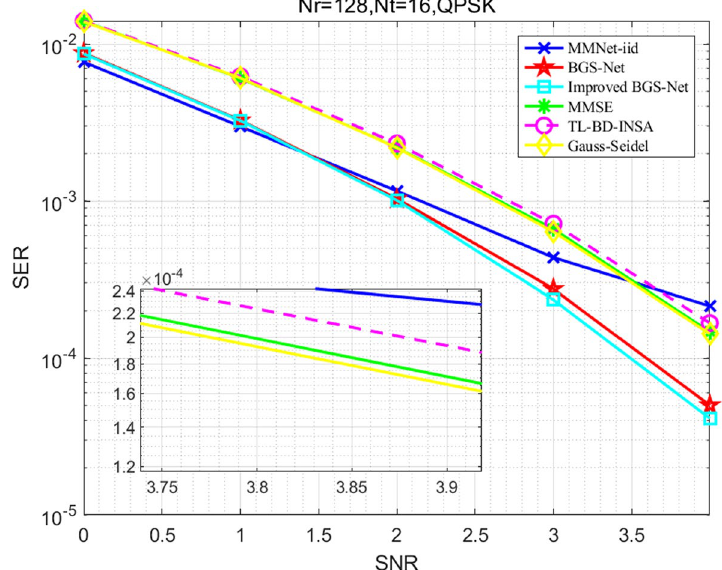
Fig. 22 SER performance comparison of different algorithms for N t = 16,N r = 128 , QPSK, MAUE system with ξ r = 0, ξ t =